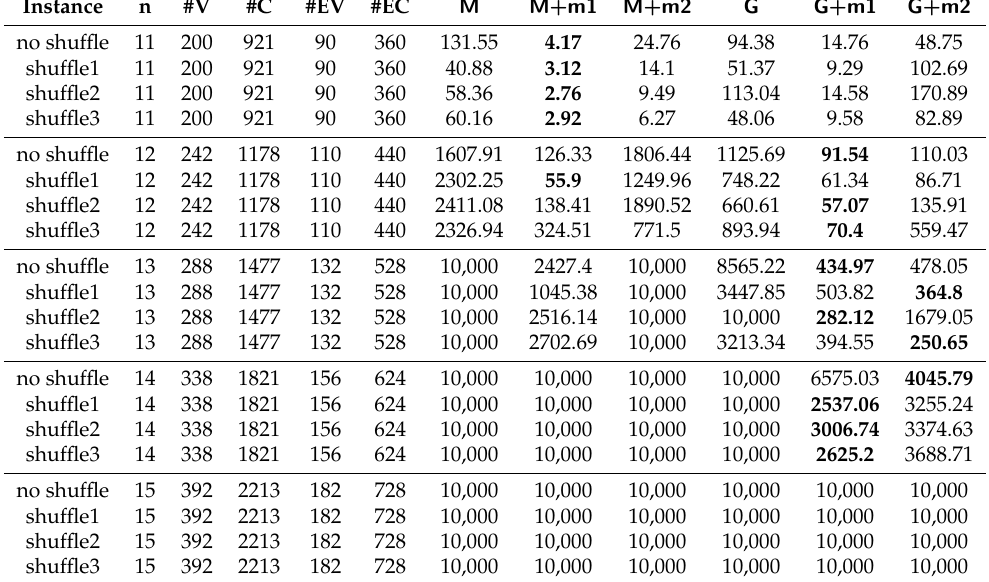
Table 2. Results of PHP instances with full